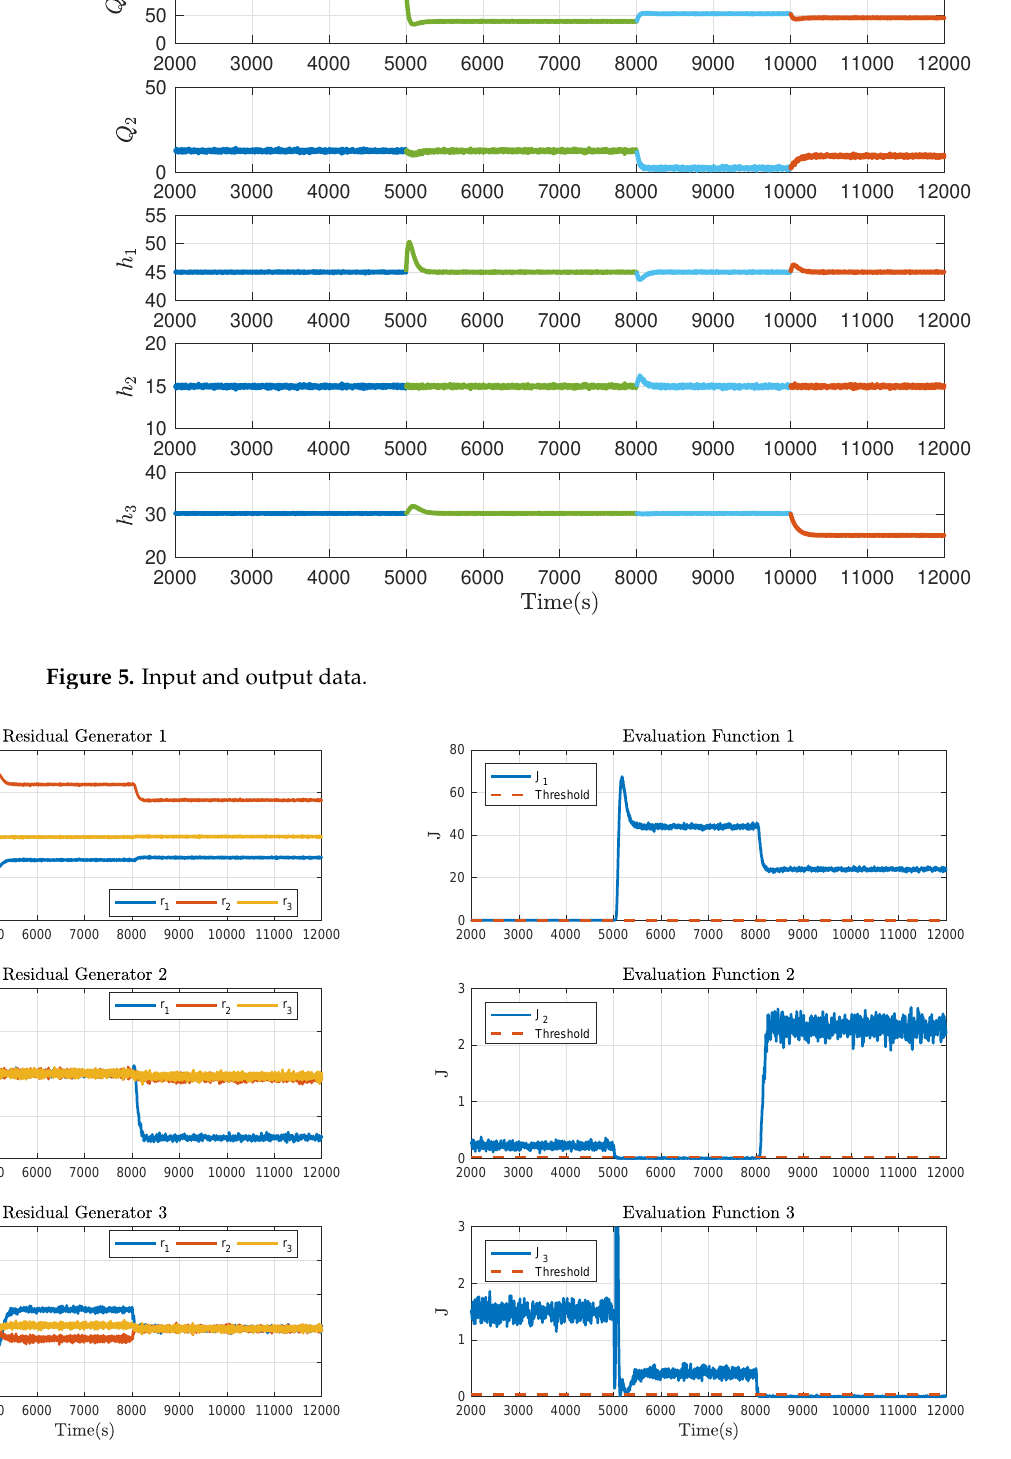
Figure 6. Residual generators, evaluation functions and thresholds designed by Algorithm